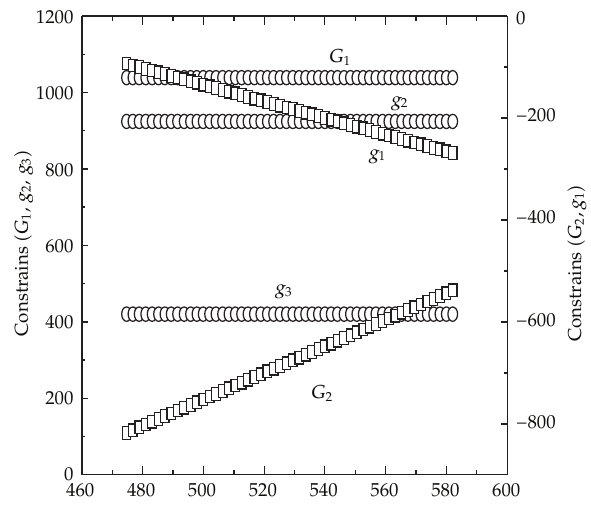
Figure 6: The constrains of Example